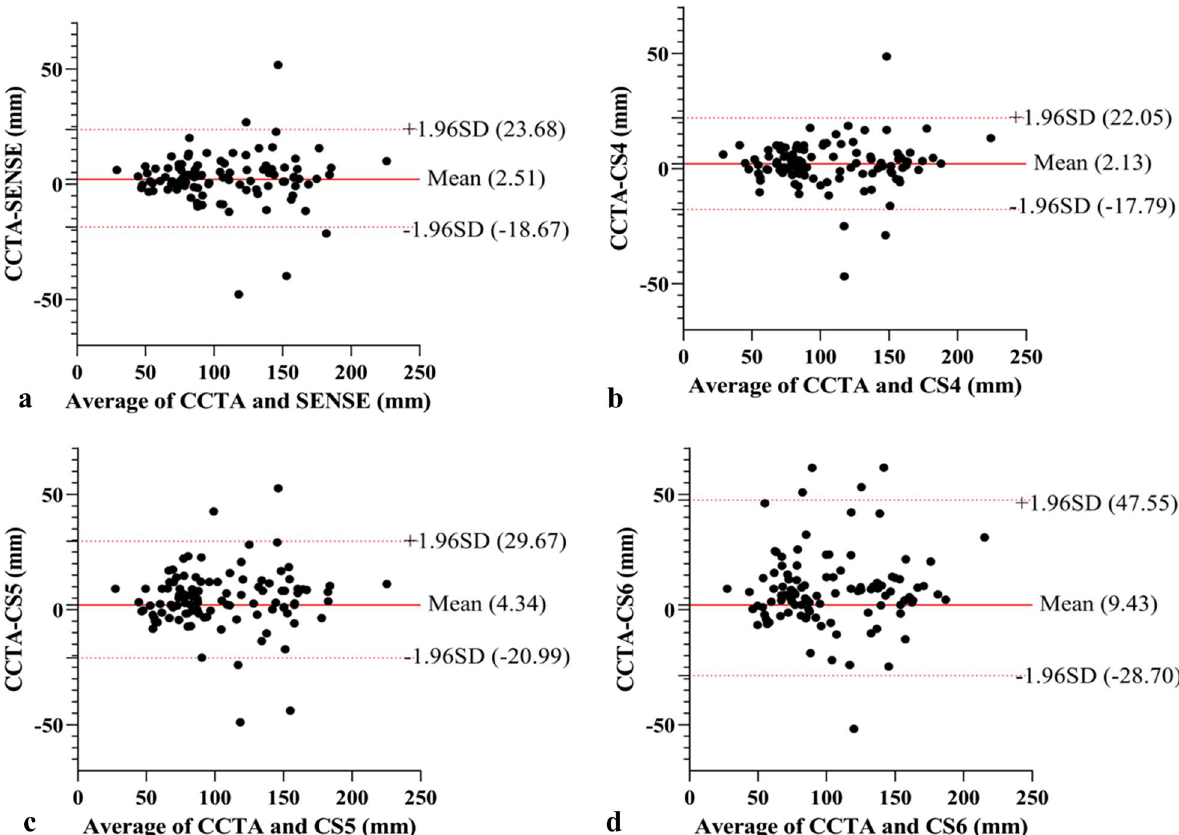
Fig. 6 Bland–Altman analysis for visible vessel lengths compared between CCTA and NCMRA sequences. a CCTA versus SENSE, b CCTA versus CS4, c CCTA versus CS5, and d CCTA versus CS6. The red solid line indicates the mean difference between CCTA and CMRA sequences; the red dashed lines indicate the 95% limits of the agreement